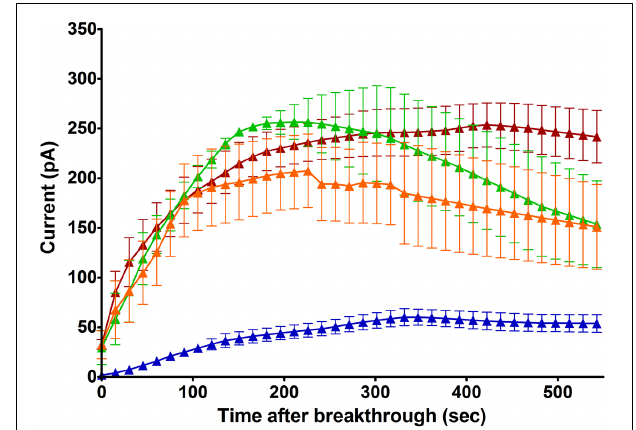
FIGURE 4 | Time course of emerging outward Cl – currents at +100 mV in mouse neutrophils (HVCN1 – / – and WT cells treated with Zn 2 + 100 µ M), normalized to Cl – driving force (Table 1), with selective internal solutions of standard or reduced ionic strength and selective external solutions. Blue trace: Untreated cells, NMDG Cl – based, standard ionic strength internal solutions [Solutions set D ( Table 1 ), n = 4]. Brown trace: Untreated cells, NMDG Cl – based, low ionic strength internal solutions [Solutions set E ( Table 1 ), n = 5]. Green trace: cells treated with PMA (1 µ M), NMDG Cl – based, low ionic strength internal solutions ( n = 3). Orange trace: cells treated with FMLP (1 µ M) and Cytochalasin B (5 µ g/ml), NMDG Cl – based, low ionic strength internal solutions, ( n = 8). The errors bars are standard error of the